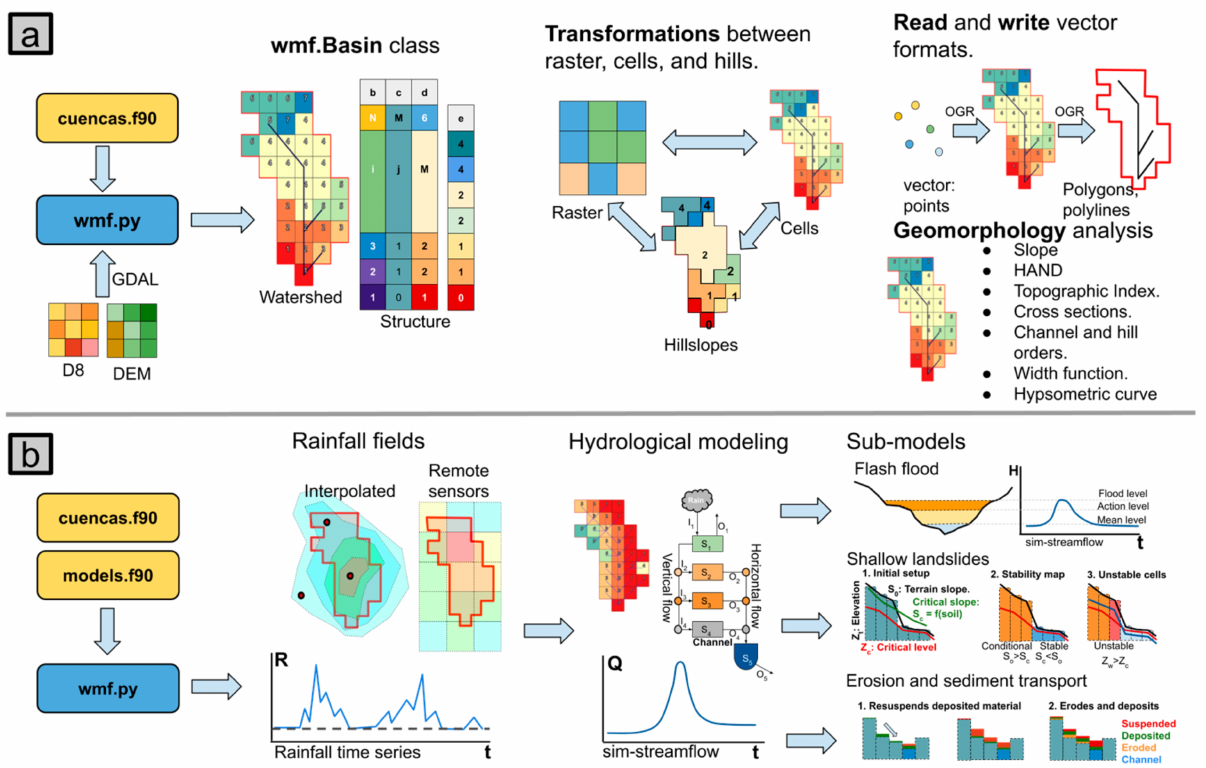
Figure 1. The general structure of WMF. wmf.py contains the functions to interact with the Fortran modules: ( a ) presents the interaction with the module cuencas.f90 , which allows watersheds to be de- fined; ( b ) describes the interaction with the models.f90 and its tools to perform hydrological modeling.